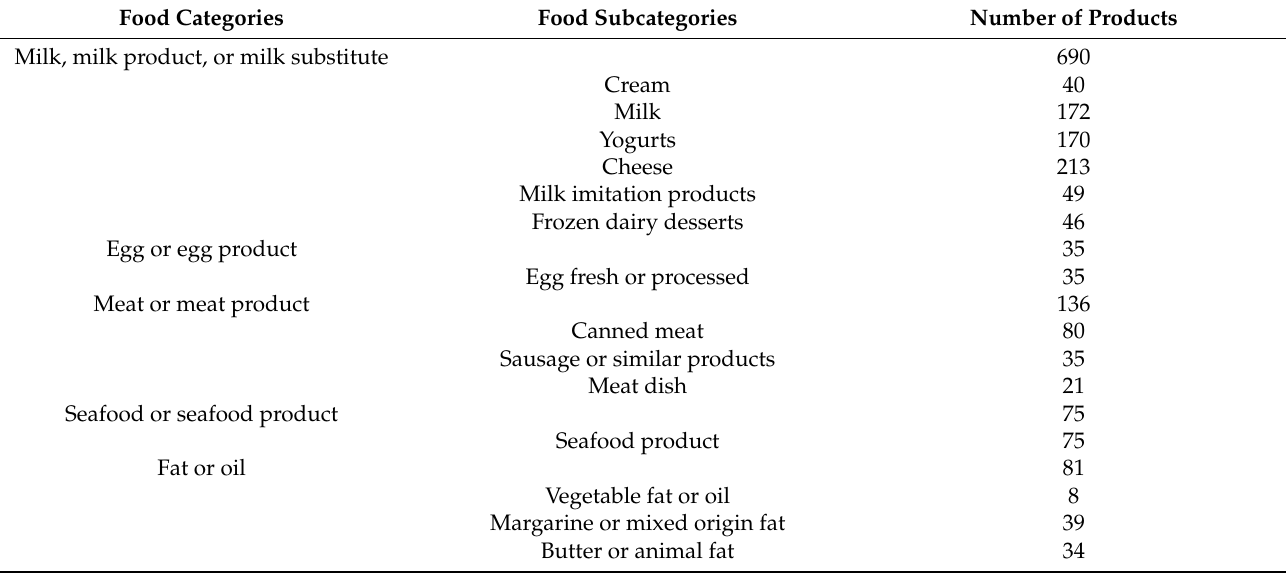
Table 1. Number of food products, per category and subcategory, in the HelTH database that presented on their labels information related to allergens (presence or